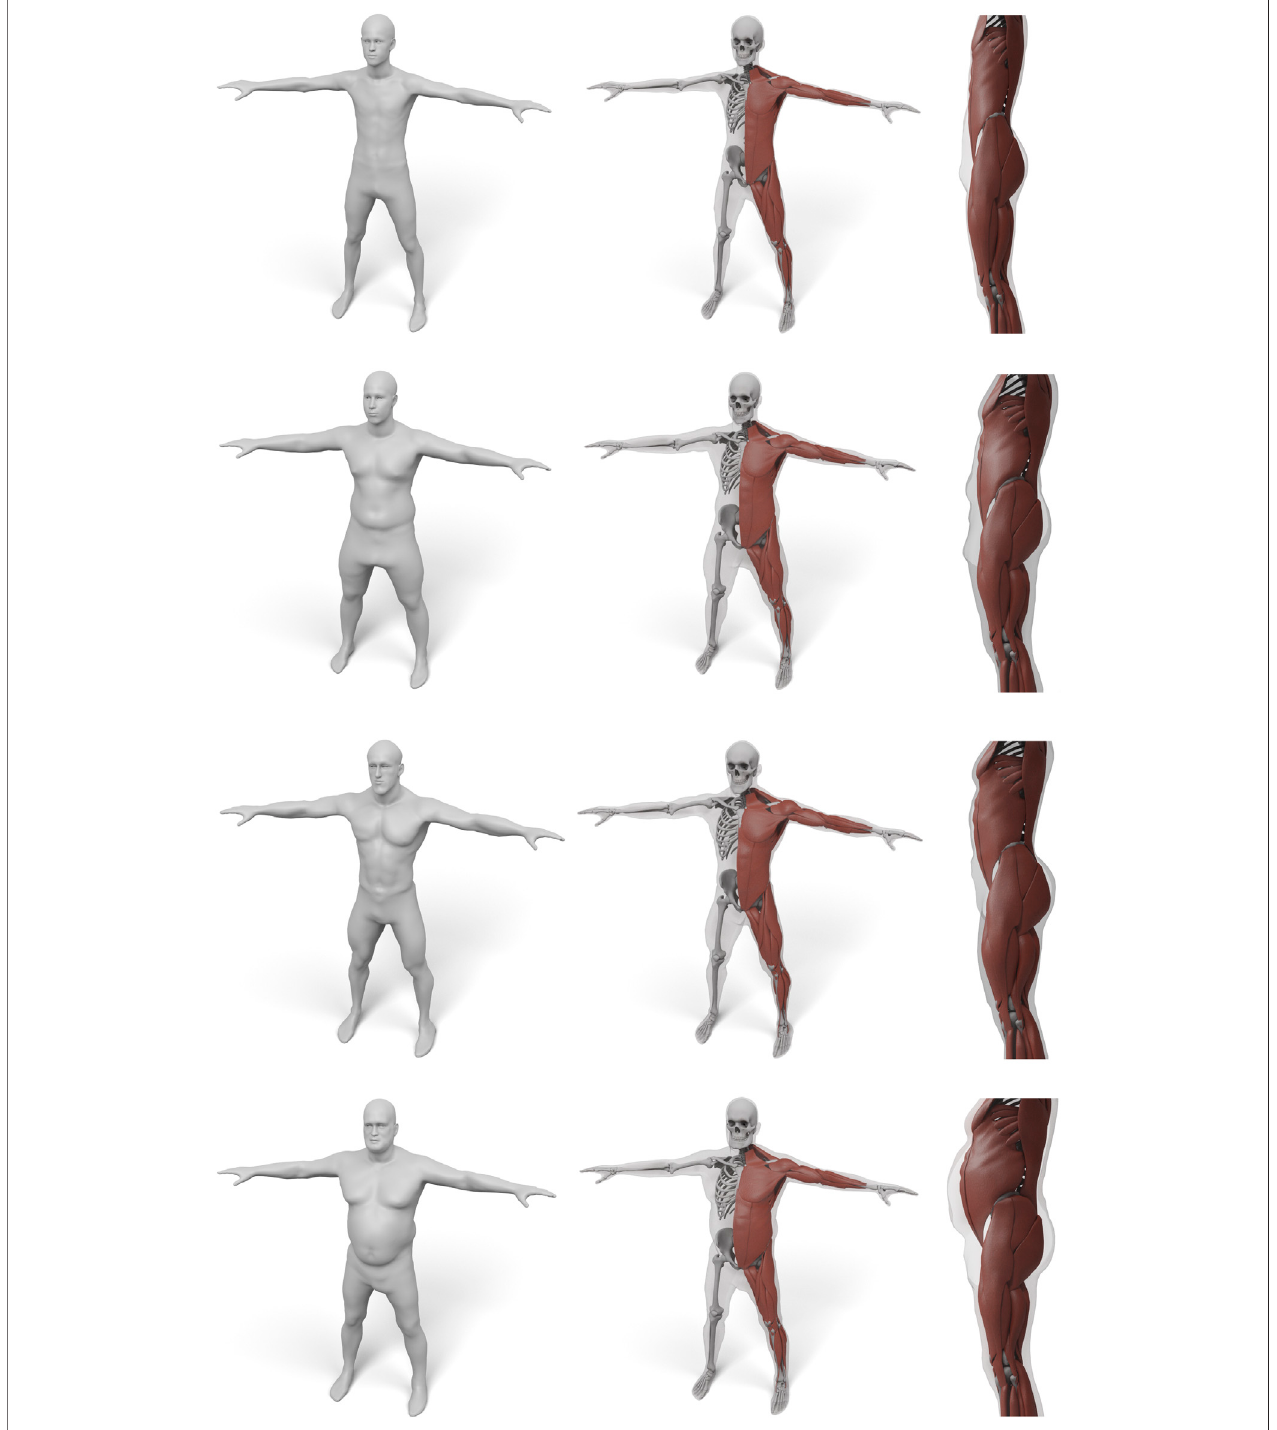
FIGURE 10 | Some examples for various male body shape types. For each input surface the transferred muscles and skeleton are shown in front and side view.